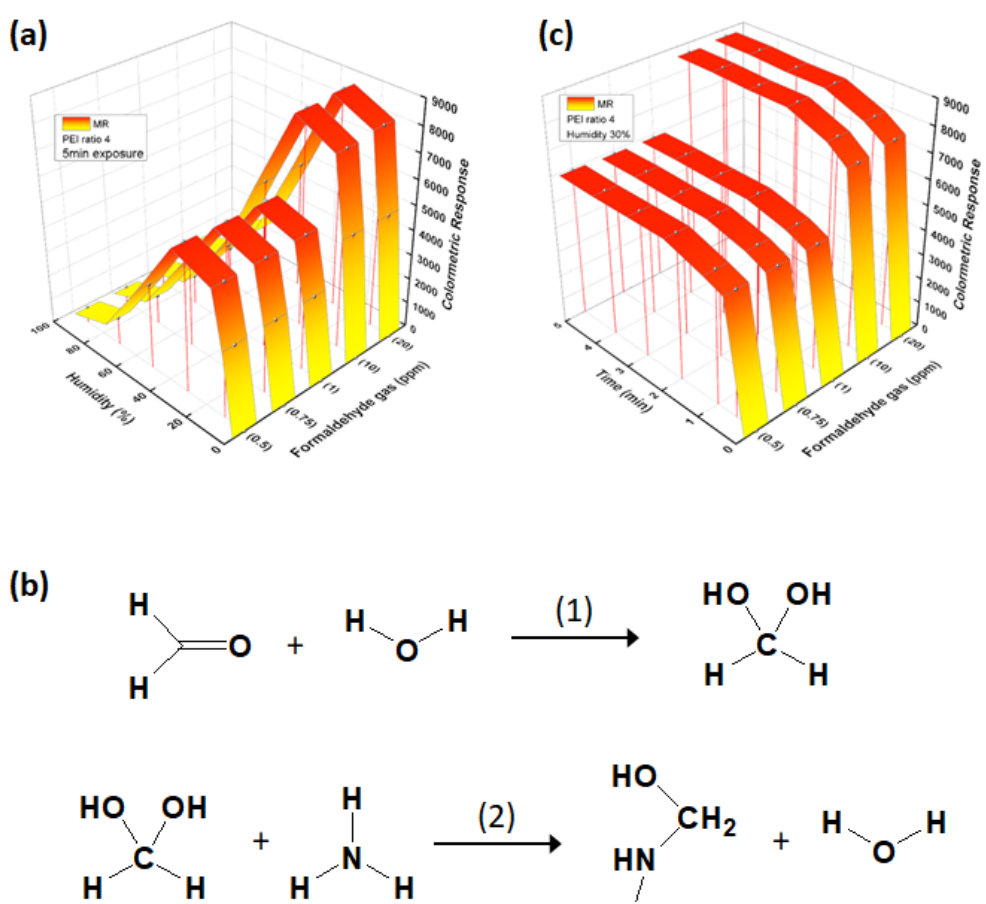
Figure 5. ( a ) Colorimetric response ( ∆ RGB values) of the MR sensor to humidity changes (30–90 RH%). ( b ) Formation mechanism of ethylene glycol via the reaction of formaldehyde with H2O. ( c ) Change in the colorimetric response ( ∆ RGB values) of the MR sensor over time (0–5 min).